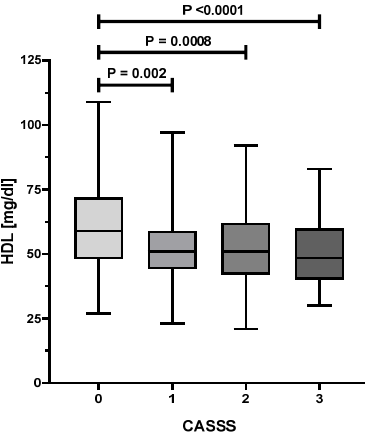
Figure 2. Association between HDL and CASS score.